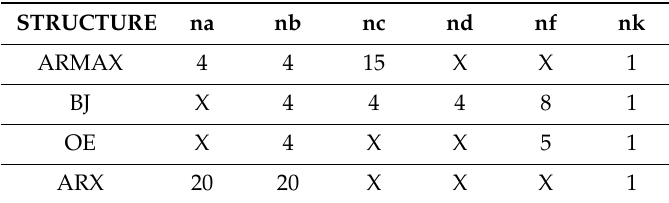
Table 1. Discrete model